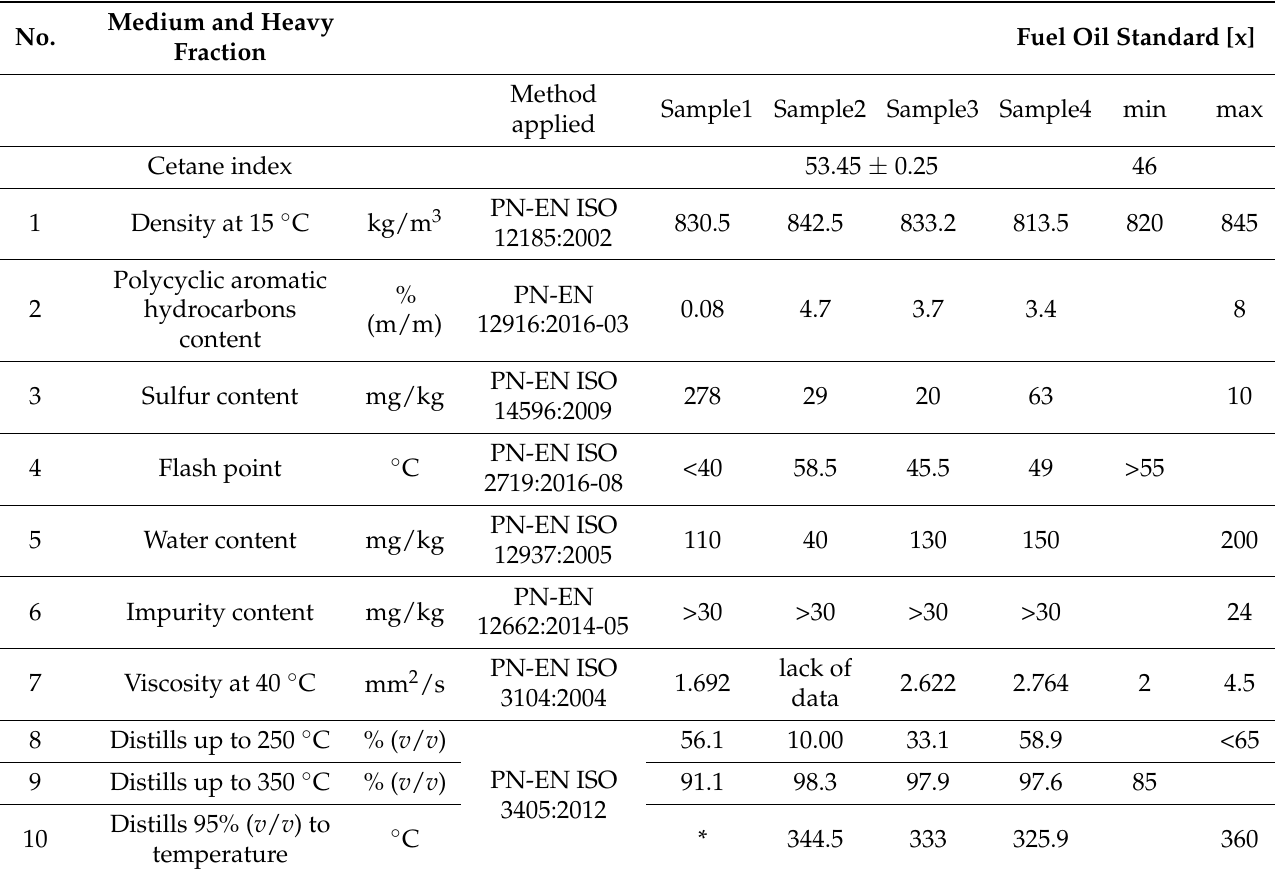
Table 5. Values of selected parameters characterizing oil fraction obtained in the technological process designed by the plant together with requirements for standard fuel